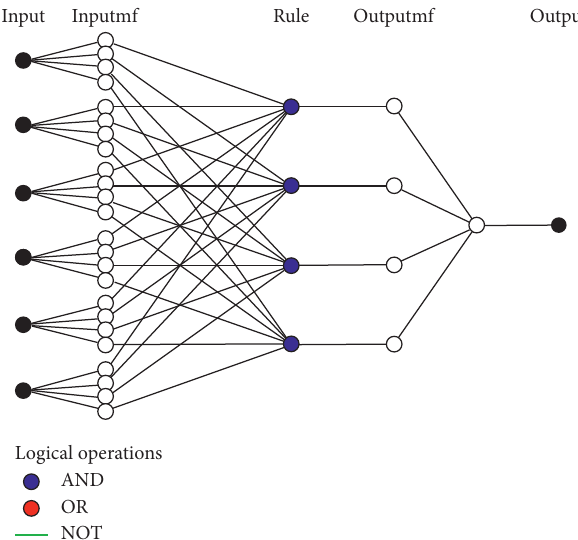
Figure 4: ANFIS architecture used in this study. A colored circle indicates a fixed node, whereas an adaptive node is indicated by a white